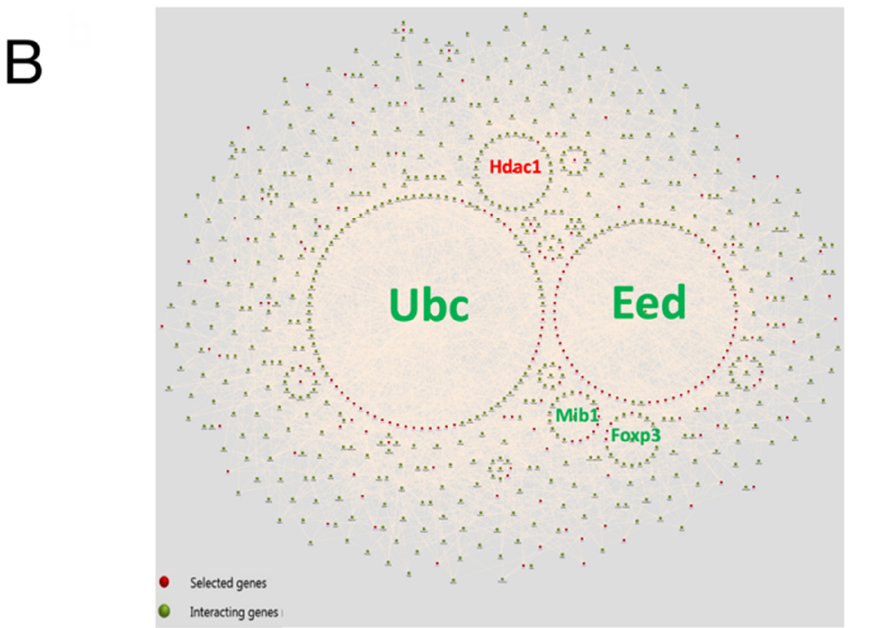
Figure 5. Interaction diagrams of proteins identified in large extracellular vesicles (EVs) and small EVs created using FunRich. The list of total proteins identified in large EVs ( A ) and small EVs ( B ) was uploaded, and interaction analysis tool was used to obtain the diagrams. The red and green spheres indicate the input proteins (selected genes) and the interacting proteins (interacting genes), respectively.